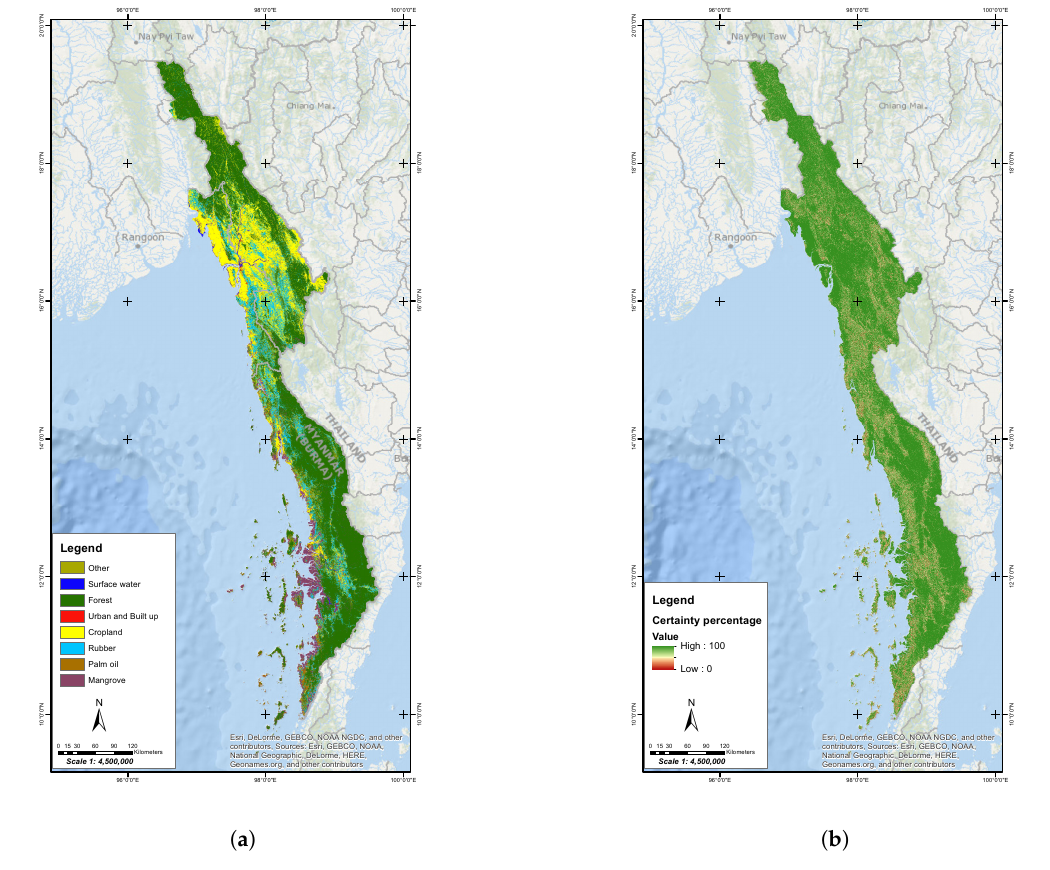
Figure 5. Landcover map for 2018 ( a ) and probability map for 2018 ( b ).